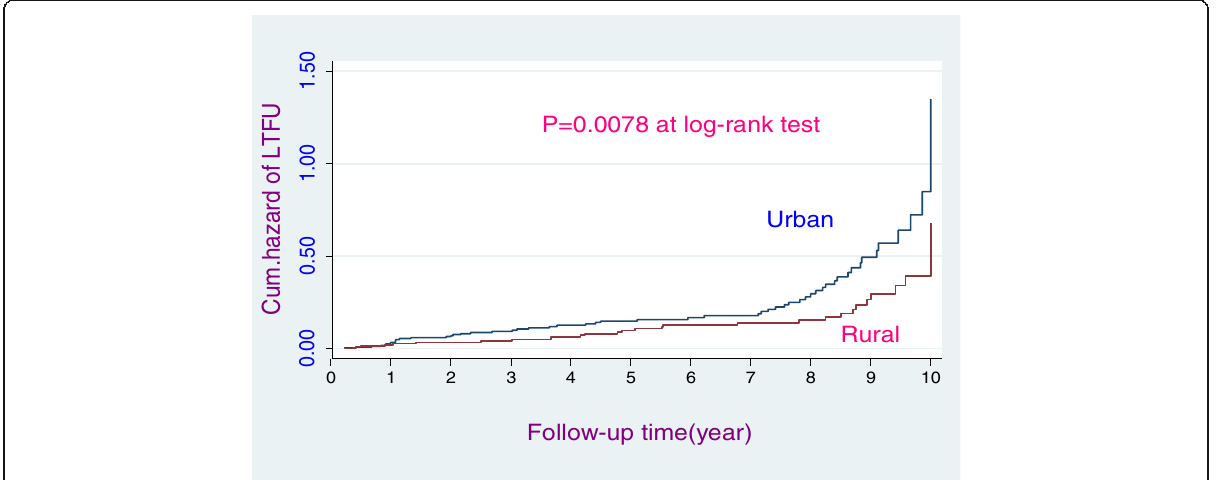
Fig. 2 The hazard rate of lost to follow-up of HIV-positive adults on ART over their place of residence from January 30, 2008, to January 26, 2018